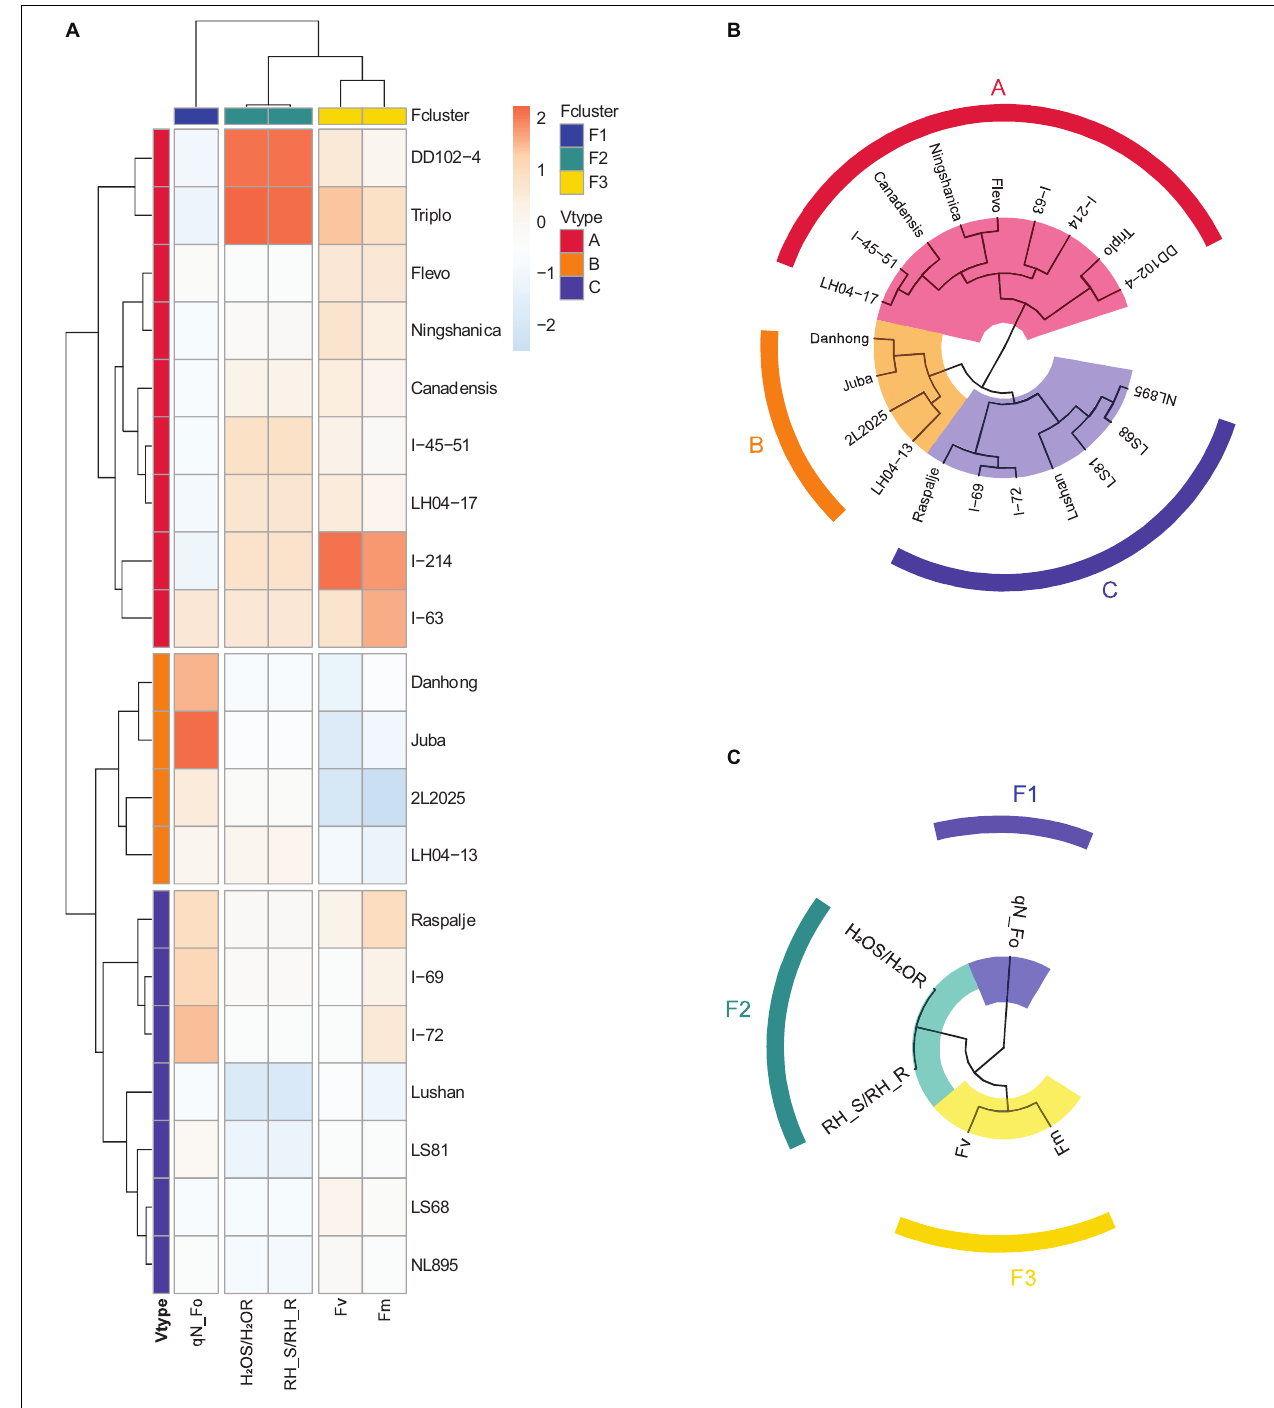
FIGURE 5 | Results of poplar features and varieties clustering. (A) Total. (B) Varieties. (C) Features.